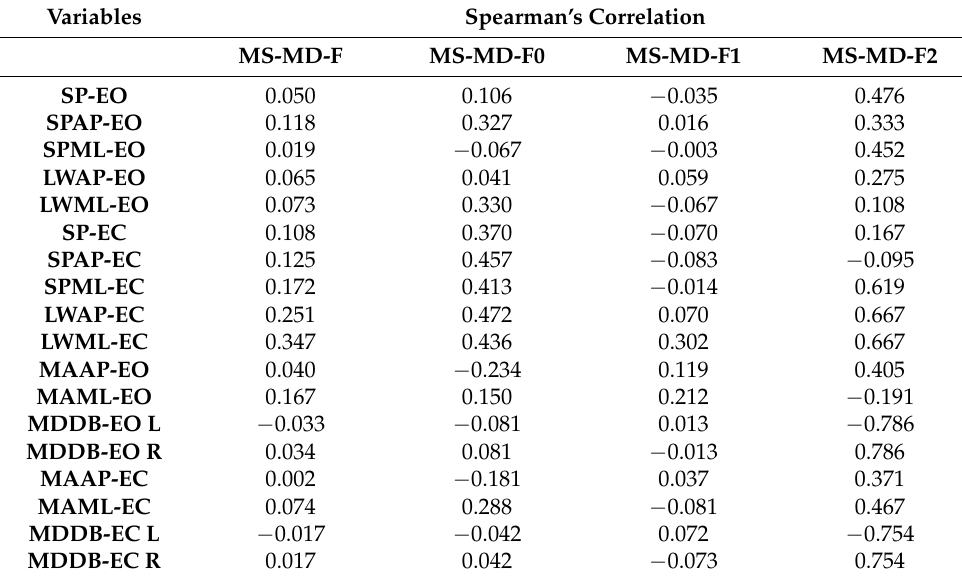
Table 4. Correlations between the results of stabilometric platform/static postural control and body mass among the participants with different cognitive disfunctions.